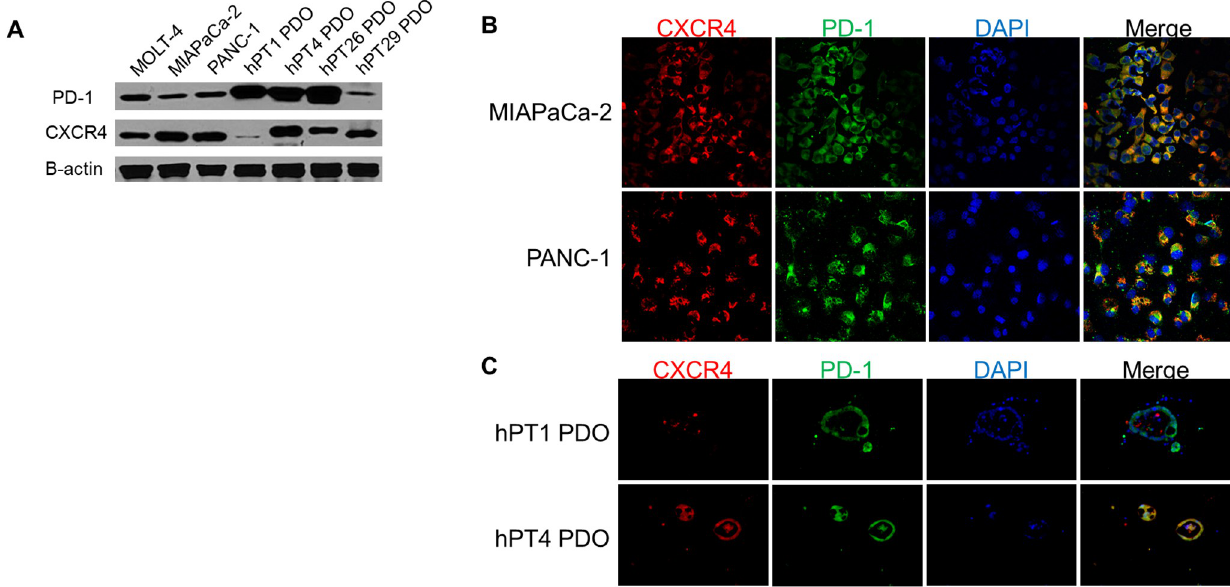
Fig 1. PD-1 and CXCR4 expression in PDAC cells and PDOs. ( A ) PD1 and CXCR4 were detected in PDAC cells and PDOs by western blot. Notably, different cell and PDO lines had unique expression patterns. MOLT-4 was used as a positive control for PD-1 and CXCR4. ( B ) IF staining shows co- expression of PD-1 and CXCR4 in PDAC cells (magnification 40X). ( C ) IF staining shows co-expression of PD-1 and CXCR4 in PDAC PDOs. Consistent with western blot results, hPT1 PDOs had lower expression of CXCR4 compared to hPT4 PDOs (magnification 20X).